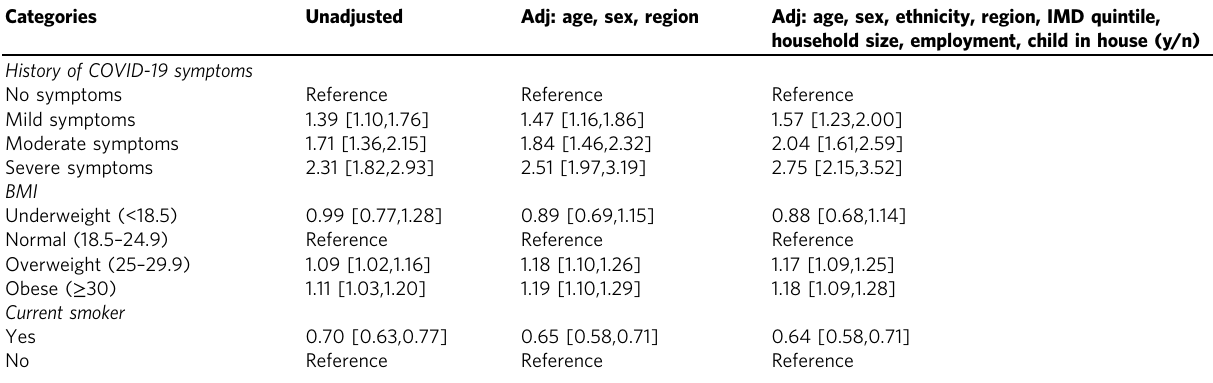
Table 2 Infection fatality ratio (IFR) and numbers of SARS-CoV-2 infections by age, sex, ethnicity.